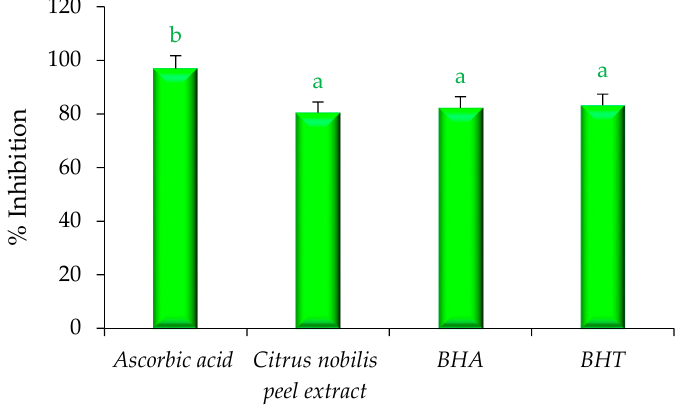
Figure 7. Antioxidant activity of Citrus nobilis peel dry extract in comparison with natural and synthetic commercially available antioxidant components. Data are presented as means ± SEM ( n = 3); a,b: Means within the column with different lowercase superscripts are significantly different ( p < 0.05).